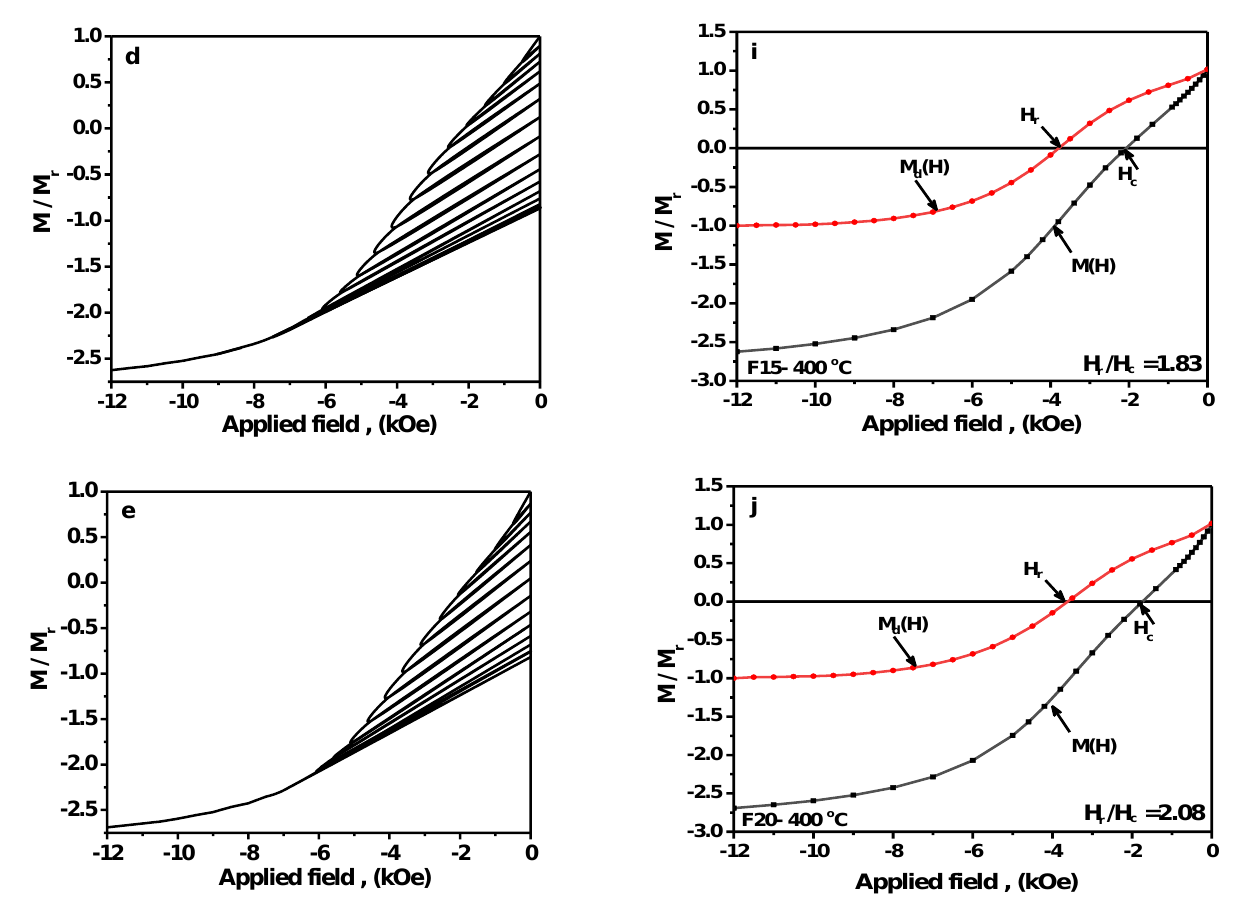
Figure 5. ( a – e ) Recoil demagnetization curves, ( f – j ) magnetization curves M(H) and dc demagnetization remanence M d (H) vs applied reversal field.